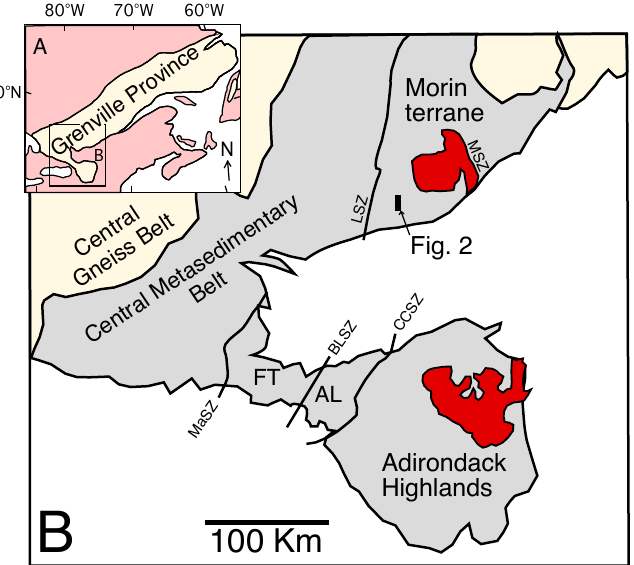
Figure 1. ( A ) Location map of the Grenville Province and ( B ) geology of the Allochthonous Monocyclic Belt, showing the Marcy and Morin anorthosite massifs after [12]. AL = Adirondack Lowlands, FT = Frontenac terrane, BLSZ = Black Lake shear zone, CCSZ = Carthage-Colton shear zone, LSZ = Labelle shear zone, MaSZ = Maberly shear zone, MSZ = Morin shear zone.